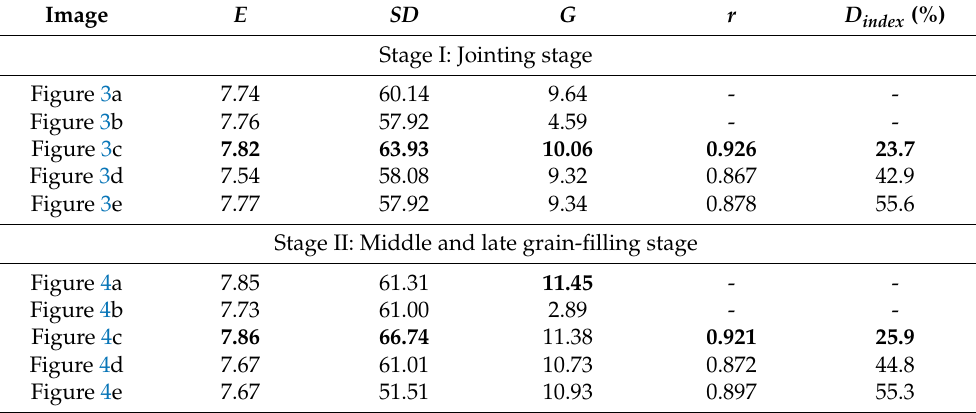
Figure 4. Comparison of fused images using our proposed method, reginal variance and IHS transform for Stage II. ( a ) Original visible image; ( b ) Original TIR image; ( c ) IHS-RVM; ( d ) Regional variance; and ( e ) IHS transform. Table 1. Comparison of quantitative indicators between pre- and post-fusion images at two growth